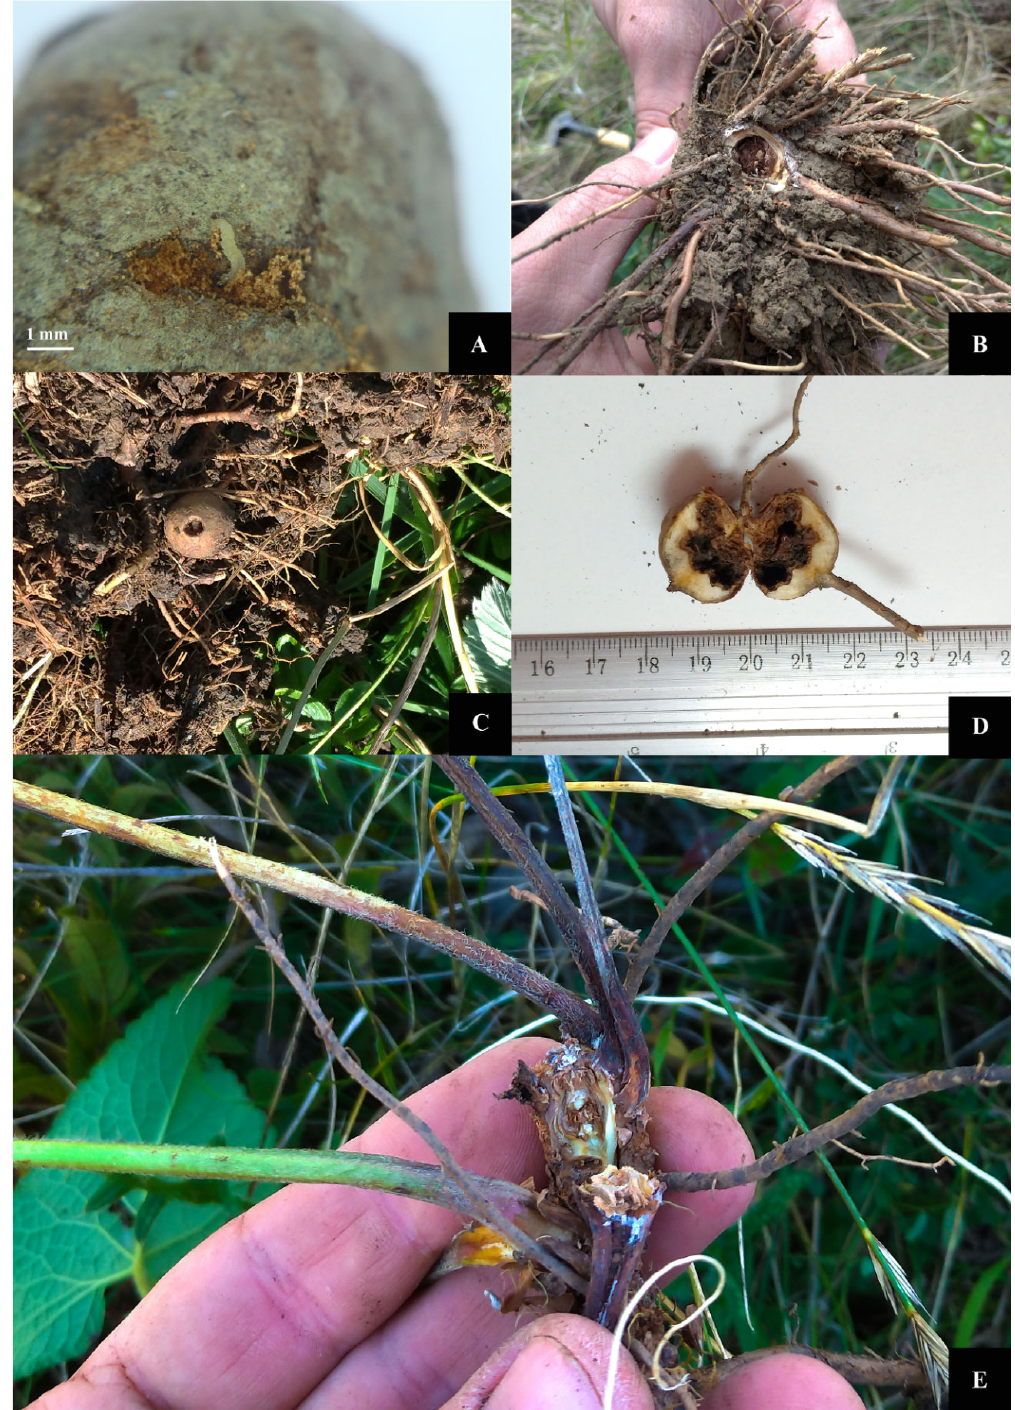
Figure 3. The pattern of damage caused by Paracossulus thrips larvae in underground stems and tuberous roots of Phlomis tuberosa : ( A ) P. thrips larva piercing the tuber of P. tuberosa; ( B ) Feeding damage on the rhizome of P. tuberosa ; ( C ) P. tuberosa tuber eaten by P. thrips caterpillar; ( D ) P. tuberosa tuber showing characteristic P. thrips larval damage; ( E ) After hatching, the larvae of P. thrips enter the stems of P. tuberosa at the base of the leaves that form the basal rosette.